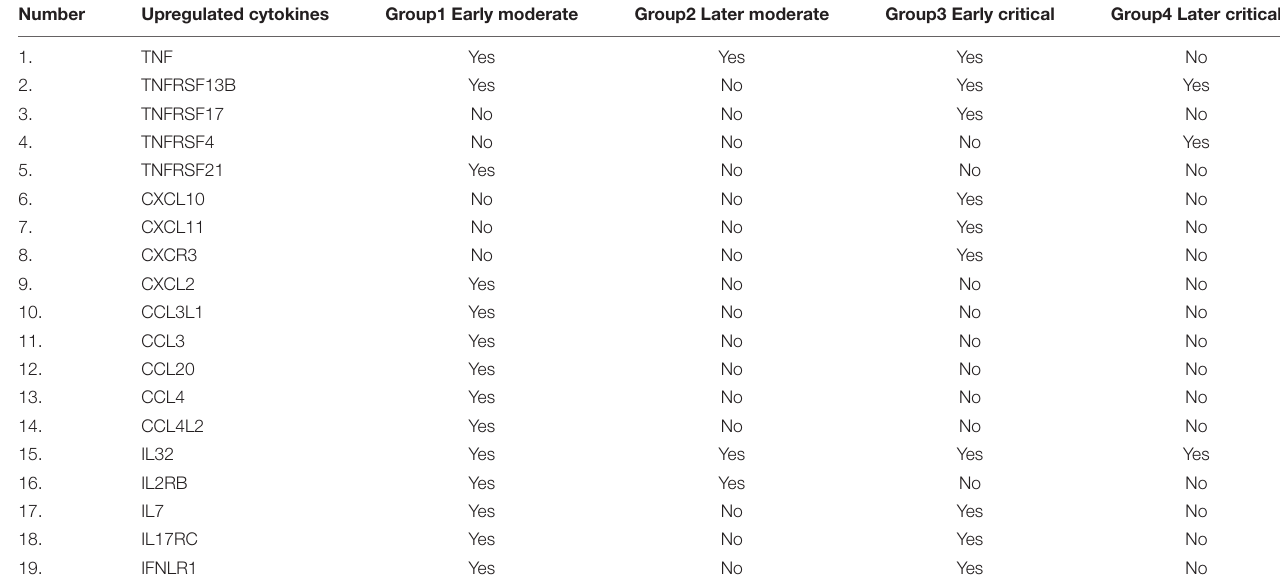
TABLE 3 | Comparison of upregulated cytokine-storm-related genes in all groups of patients. Number Upregulated cytokines Group1 Early moderate Group2 Later moderate Group3 Early critical Group4 Later